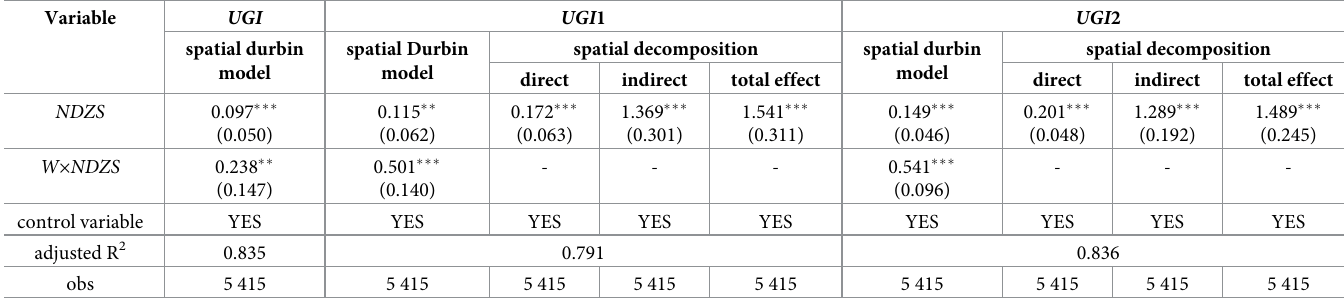
Table 2. Baseline regression